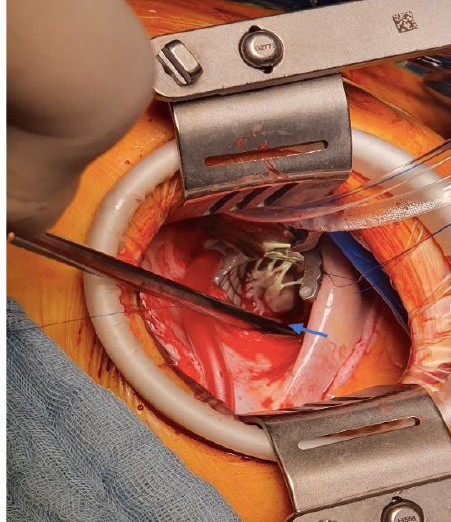
Figure 3. Left ventricle tumour implanted at the base of the anterolateral papillary muscle (blue arrow).